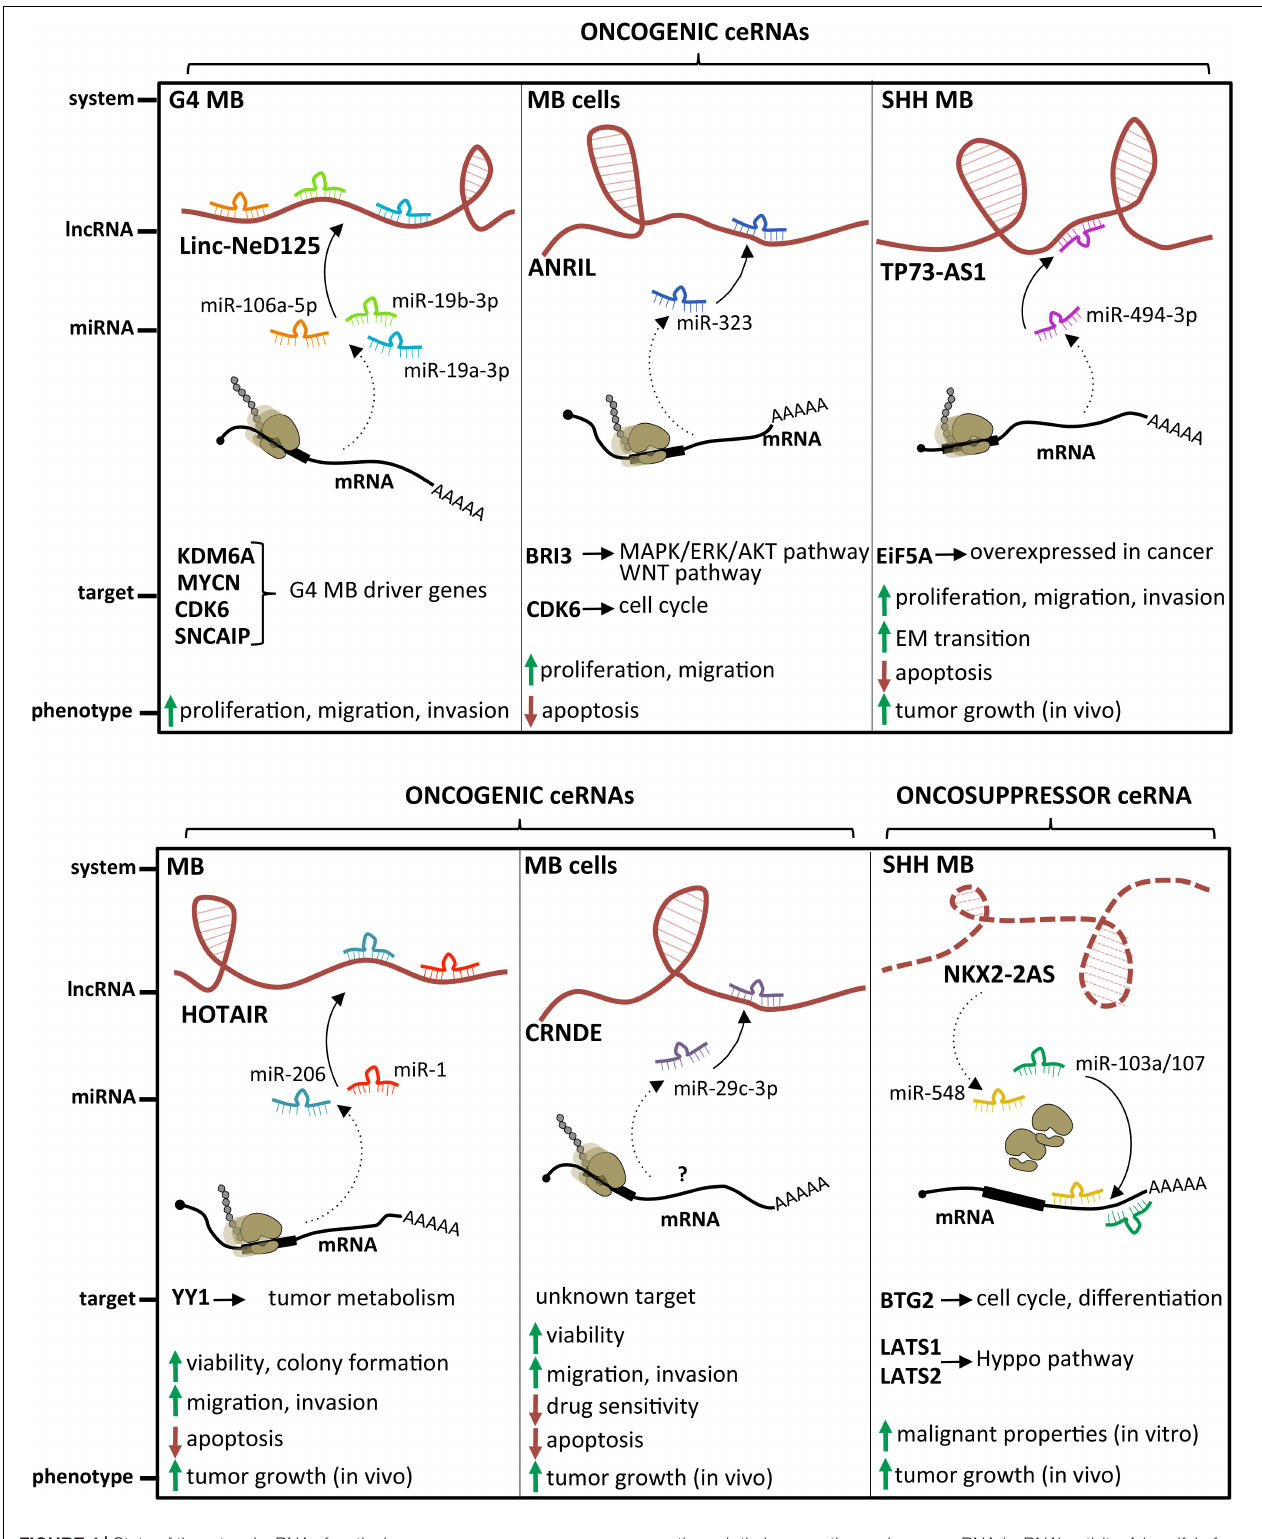
Frontiers in Cell and Developmental Biology |